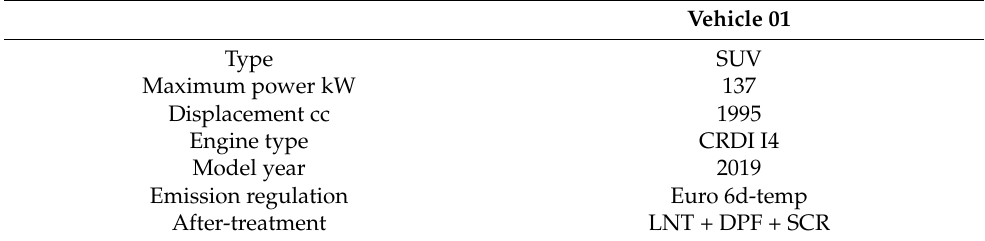
Table 4. Specifications of test vehicle